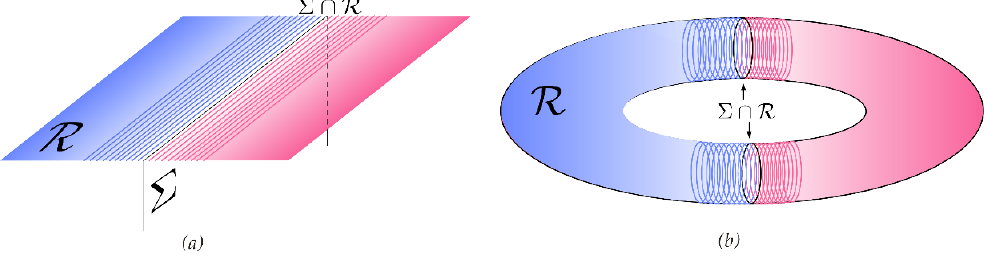
Figure 3 . (a) The hypersurface intersects the interface (cid:6) transversely. In the \coupled wire R construction," is foliated by one dimensional wires each hosting a bosonic theory. In the contin- R uum, supports a connection that breaks up into components normal and tangent to (cid:6). (b) R possess noncontractible cycles and correspondingly the bosonic theory will contain winding